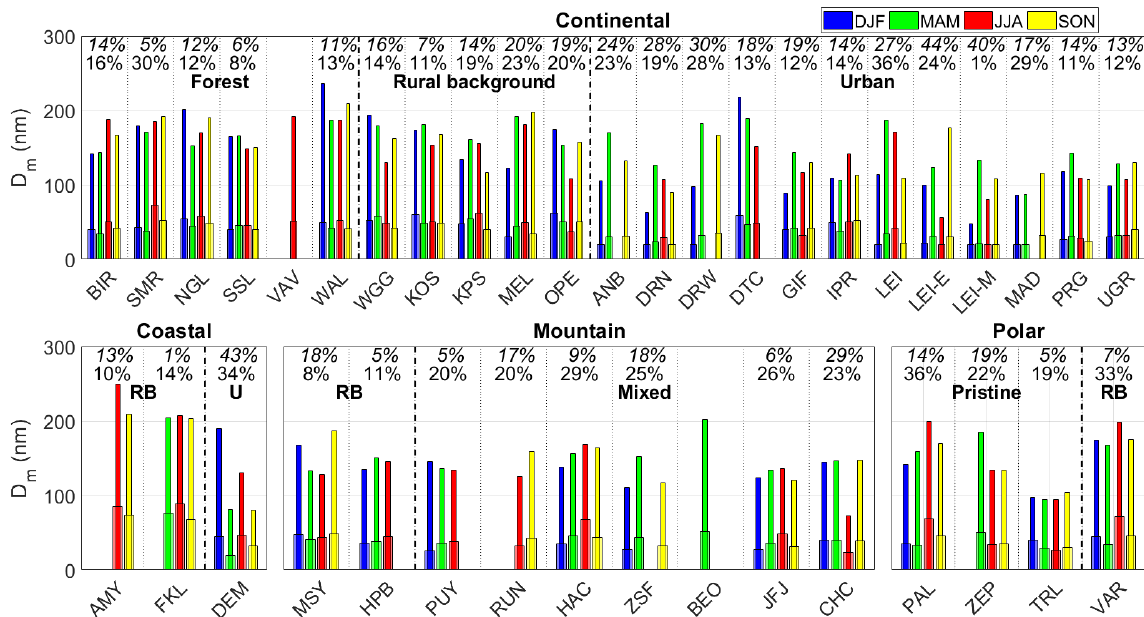
Figure 9. Mode peak locations. For each site and season, the thicker bar represents the mean diameter of the Aitken mode ( D m , 1 ) and the thinner one that of the accumulation mode ( D m , 2 ). The values at the top of each panel indicate the site-specific variability of the position of the modes, with the italicized text corresponding to D m , 2 . The meaning of the abbreviations used for the footprint is the following: RB for rural background and U for urban. Details regarding the calculation of the site-specific variability of the mode characteristics are available in Sect.